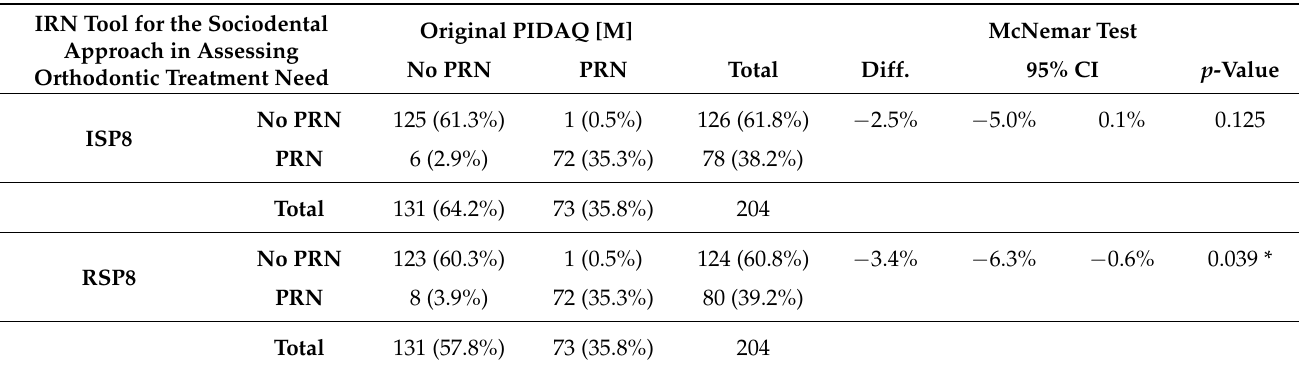
Table 4. Sociodental estimates of orthodontic treatment need when using simplified and original forms of the PIDAQ[M] as the impact-related need instrument (N = 204).